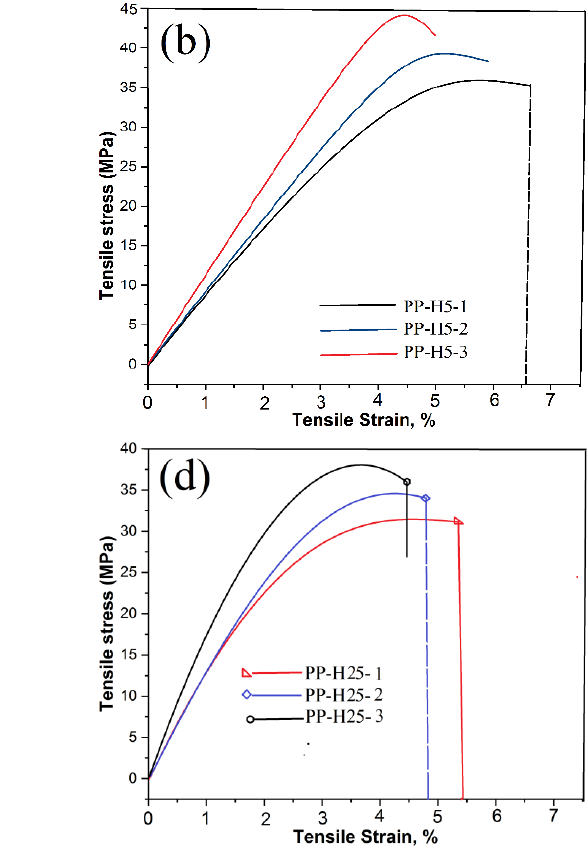
Figure 2. Relationship between tensile stress and strain for ( a ) Virgin PP, ( b ) PP-H5, ( c ) PP-H15 and ( d ) PP-H25 systems containing 1, 2 and 3 wt.% of GNPs.